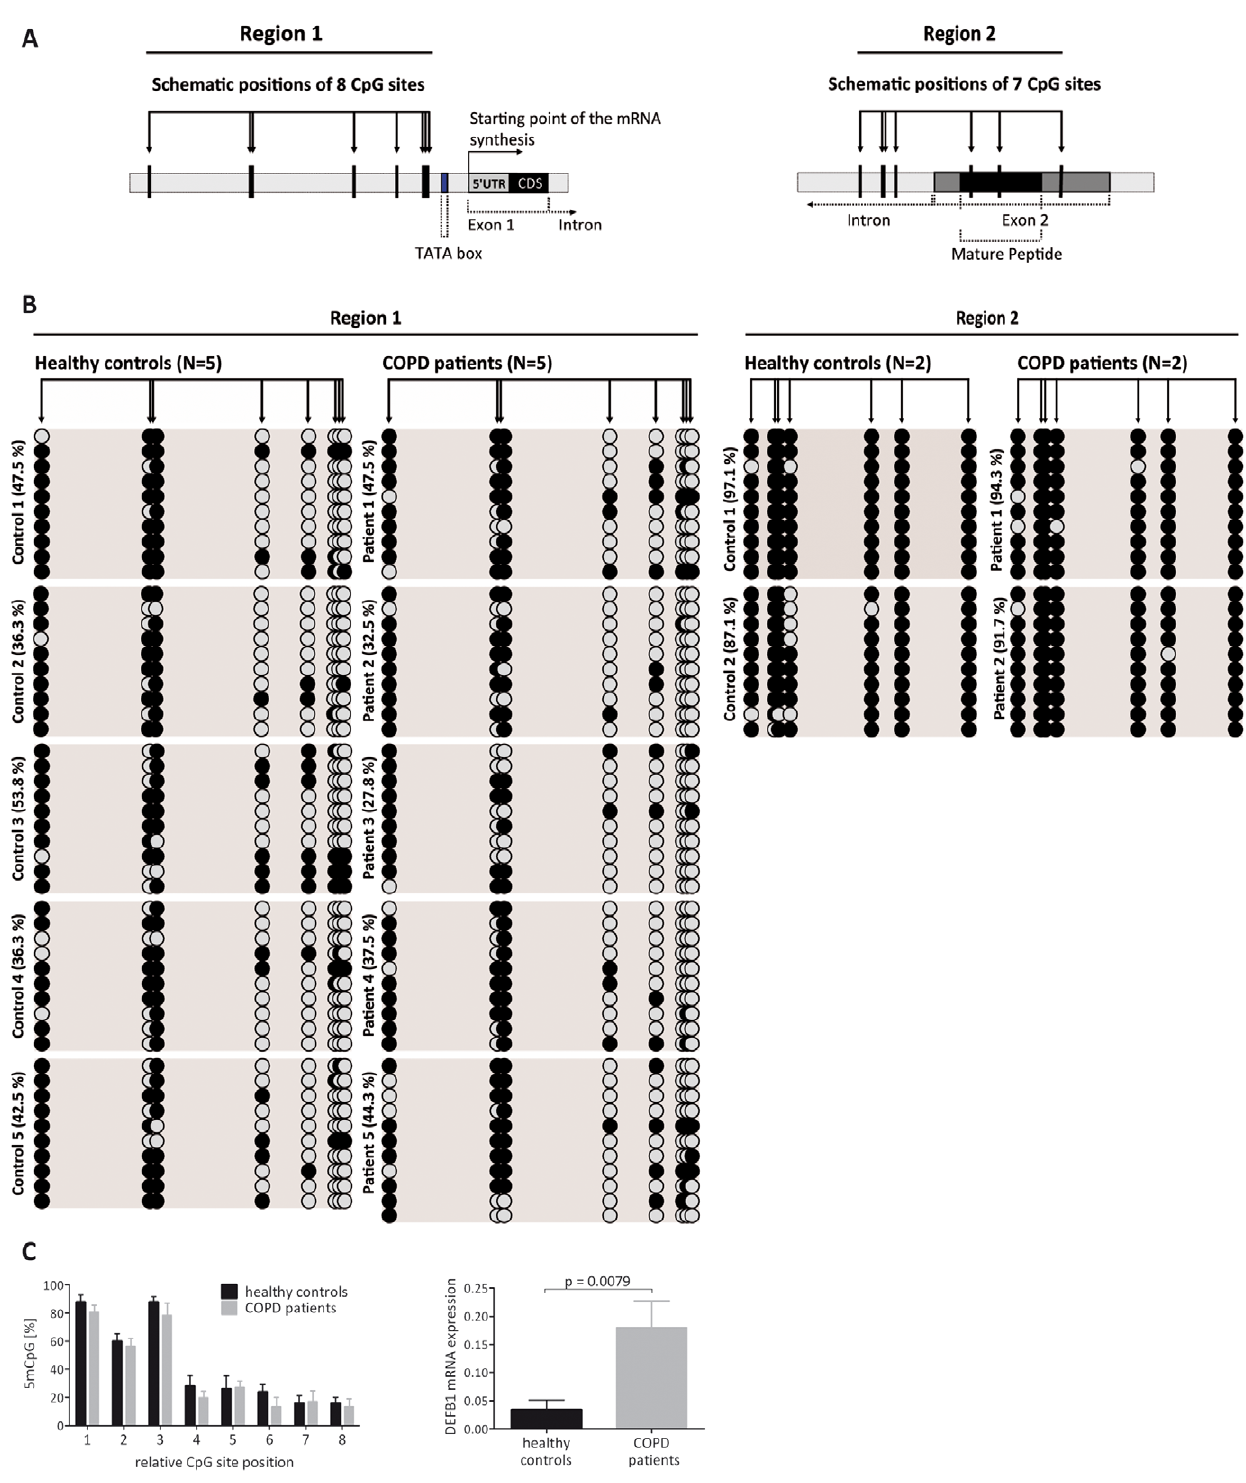
Figure 3. Bisulfite sequencing analysis of CpG methylation in bronchial epithelial cell biopsies. ( A ) Schematic view of the DEFB1 gene (NCBI GeneID: 1672) with exons displayed as filled boxes; the transcriptional start site is indicated; coding sequences are marked in black and 5 9 -UTR is shown in gray. Vertical arrows represent locations of eight CpG sites on the DEFB1 promoter (region 1) relative to the transcriptional start site and seven CpG sites on the DEFB1 downstream part of intron and exon 2 (region 2). ( B ) Bisulfite sequencing analysis of CpG methylation in bronchial epithelial cell biopsies of patients with COPD and healthy controls (both, N=5 for region 1, N=2 for region 2). Genomic DNA was treated as described, amplified by PCR and cloned for sequencing. At least 10 individual sequences (clones) were sequenced and analyzed per study subject. Each sequence (clone) is represented by a row and clones from the same subject are grouped. The individual CpG sites are arrayed in columns. Filled circles indicate methylated CpG; open circles indicate unmethylated CpG. ( C ) Average percentage of methylation for each CpG site of region 1 and levels of the corresponding DEFB1 mRNA expression for patients with COPD (N=5, gray bars) and healthy controls (N=5, black bars). Results are presented as mean 6 SEM.